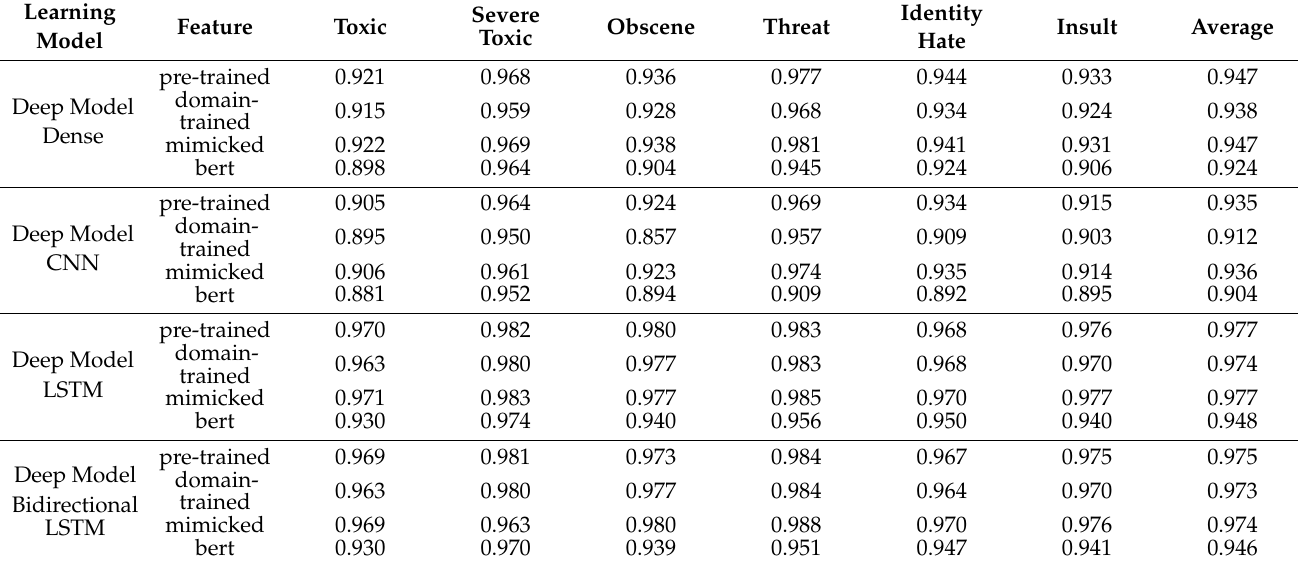
Table 2. Receiver Operating Characteristic Area Under the Curve (ROC-AUC) values of our deep learning models on each binary classification and average for each